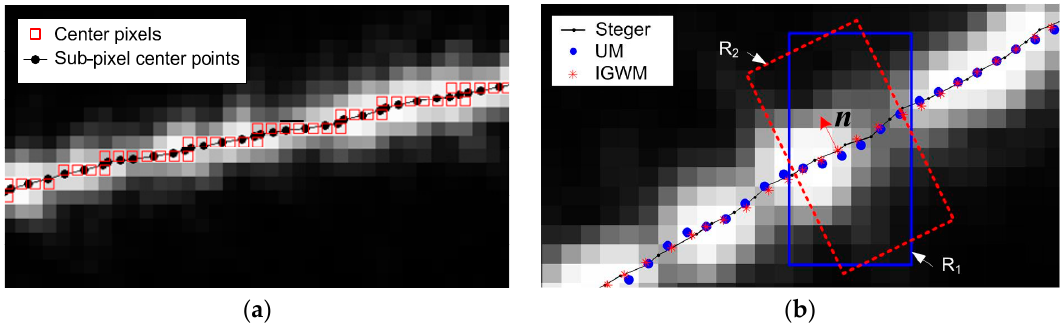
Figure 7. Center extraction results by different methods: ( a ) Steger method, ( b ) Comparision of the center extraction results.